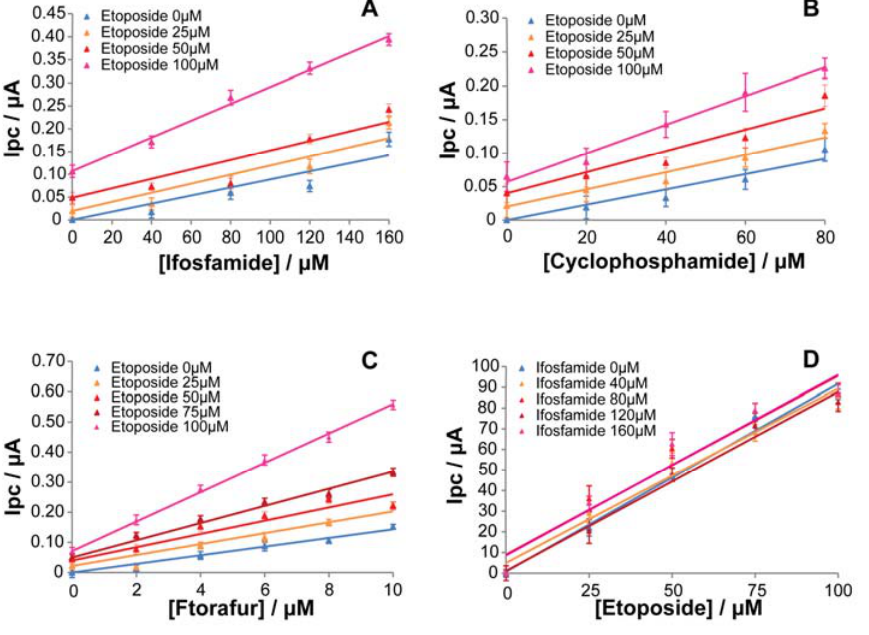
Figure 6. Calibration curve families. Cyclic voltammetric measurements, in PBS, obtained for all drugs in their pharmacological range and etoposide at fixed concentrations (0–25–50–75–100 μ M). Cytochrome P4503A4 was used for ifosfamide ( A ), cytochrome P4503A4 for cyclophosphamide ( B ), and cytochrome P4501A2 for ftorafur ( C ). Calibration curves for etoposide detection in its pharmacological range obtained with a CNT-electrode in presence of ifosfamide at fixed concentrations (0–40–80–120–160 μ M) are illustrated in ( D